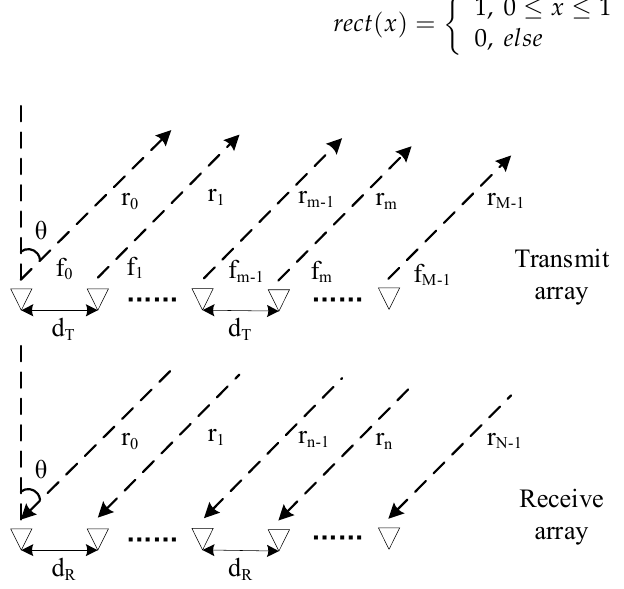
Figure 1. The structure diagram of FDA-MIMO.